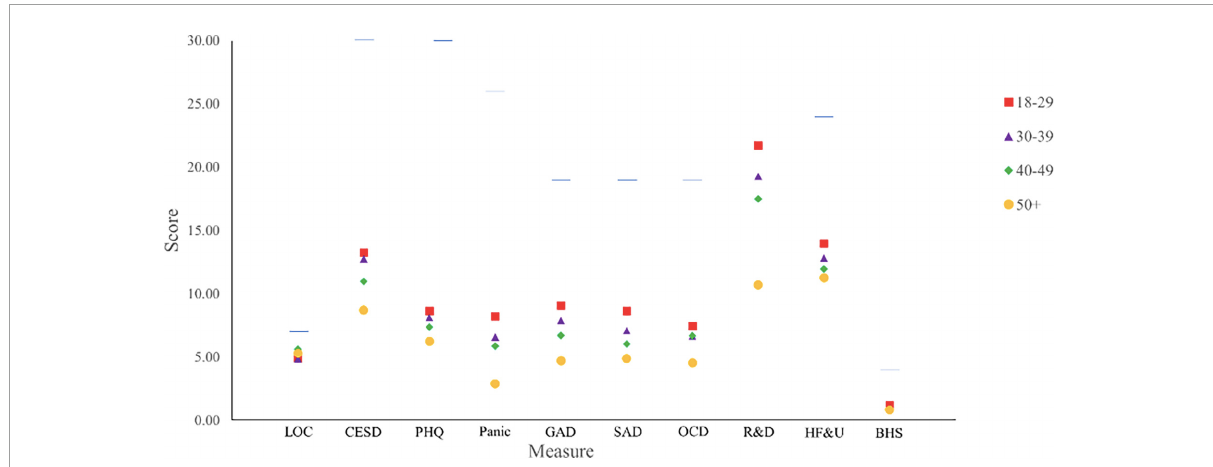
FIGURE1 Average scores on mental health measures by age group. Figure displays maximum score for each measure with horizontal line. The maximum score for the R&D subscale is 44 and is not shown due to space. LOC, Locus of Control scale; CESD, The Center for Epidemiologic Studies Depression Scale-Revised Short Form; PHQ, Patient HealthQ uestionnaire-15; Panic, Panic subscale of the SCARED-A; GAD, Generalized Anxiety subscale of the SCARED-A; SAD, Social Anxiety subscale of the SCARED-A; OCD, Obsessive Compulsive subscale of the SCARED-A; R&D, Restriction and Disconnection subscale of the C19PDS; HF&U, Health Fears and Uncertainty subscale of the C19PDS; BHS, Beck Hopelessness Scale.